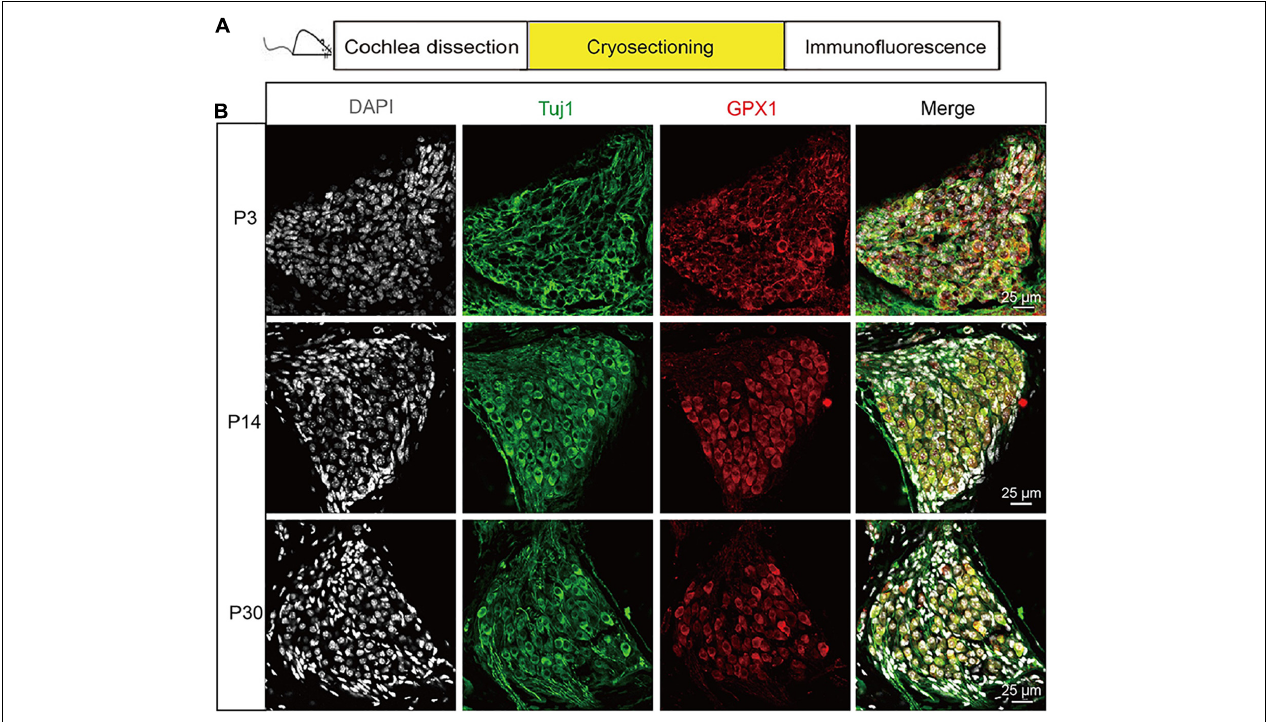
FIGURE 1 | The expression of GPX1 in postnatal cochlear spiral ganglion neurons (SGNs) with mice at different ages. (A) Immunofluorescence staining was performed on the frozen cochlear cryosection of P3, P14, and P30 C57BL/6 mouse cochlea. (B) Immunostaining images of the middle turn cochlea showed that robust GPX1 labeling was observed in cochlear SGNs of P3, P14, and P30 mice, and it appeared that the expression of GPX1 was mainly in the cytoplasm but not in the nuclei of SGNs. Scale bar = 25 µ